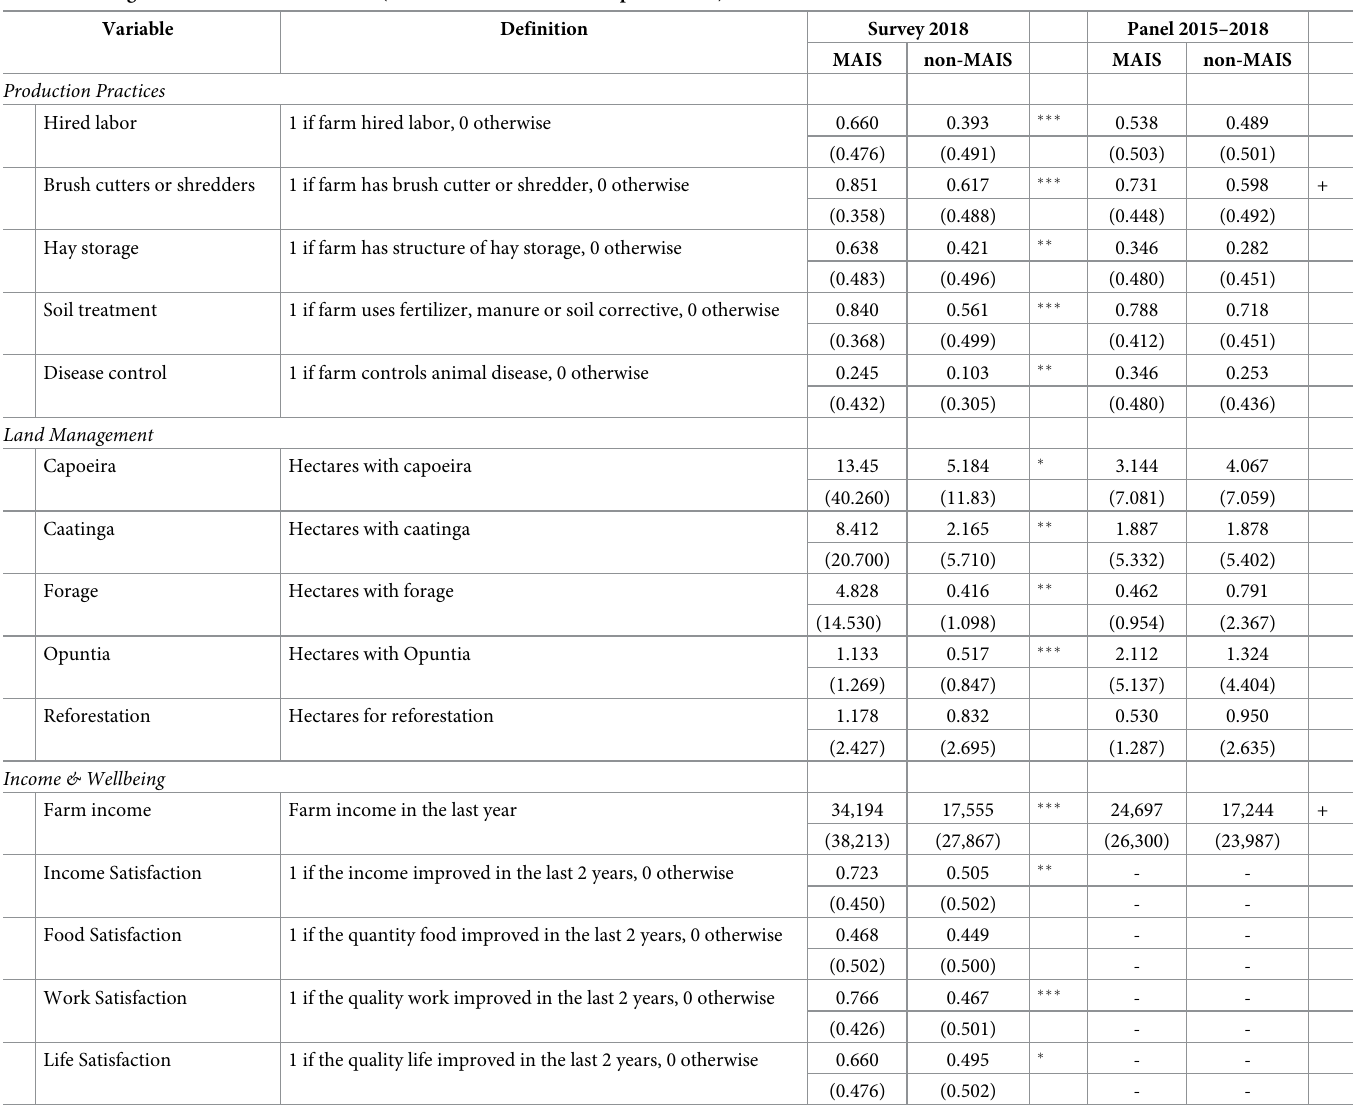
Table 1. Average values of outcome variables (standard deviation between